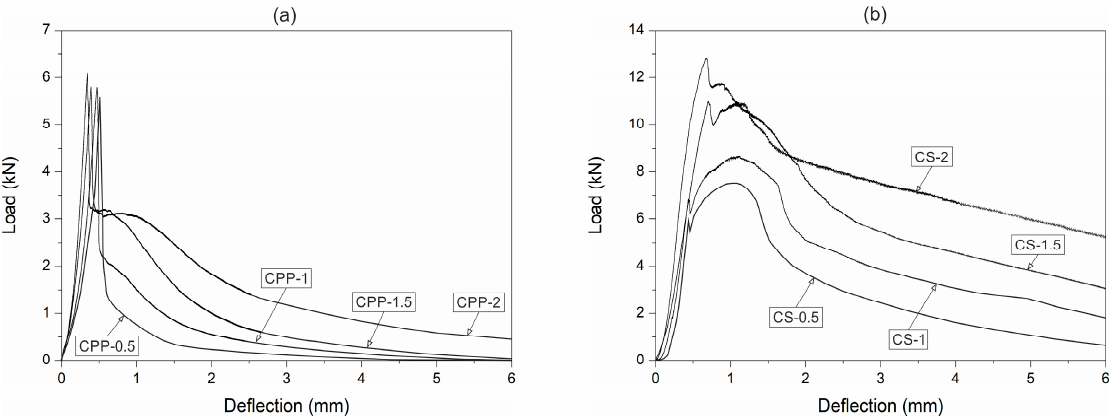
Figure 4. Load–deflection response of: ( a ) CPP and ( b ) CS fibre concretes at room temperature.